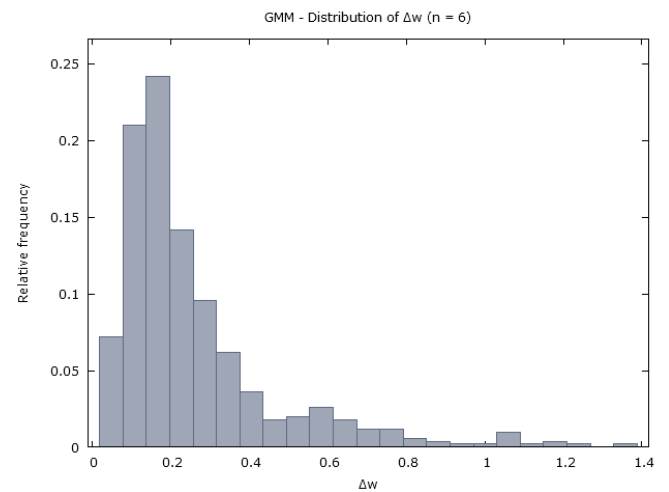
Figure 8. Sensitivity of the GMM: frequency distribution, n = 6.